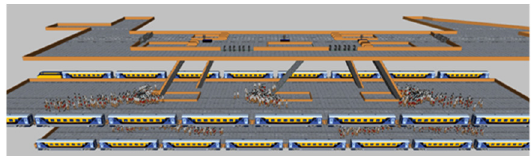
Figure 13. Pedestrian distribution in 3D view at 10 s.